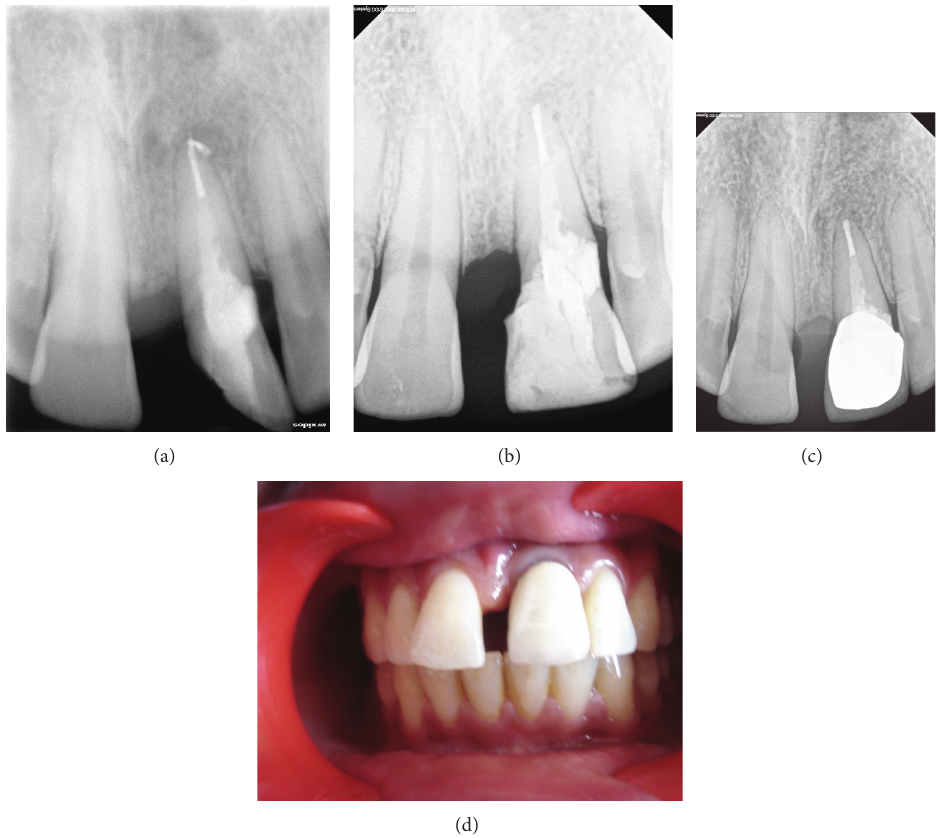
Figure 2: (a) Radiograph showing a complete root canal treatment. (b) 1-year followup showing no sign of Periapical pathosis. (c) 4-year followup radiograph. (d) 4-year followup clinical